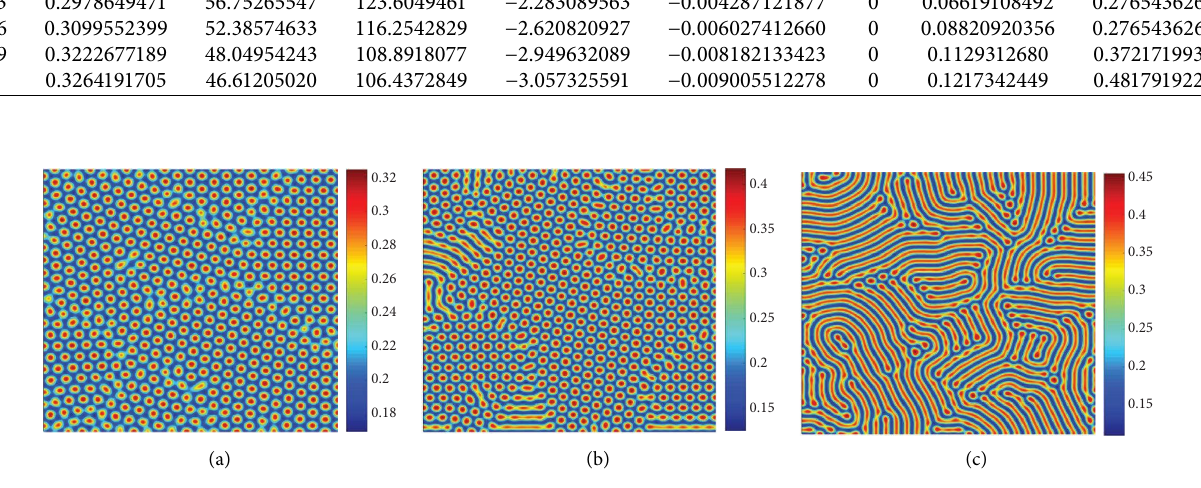
Figure 1: Pattern selection when q � 0 . 3: (a) μ